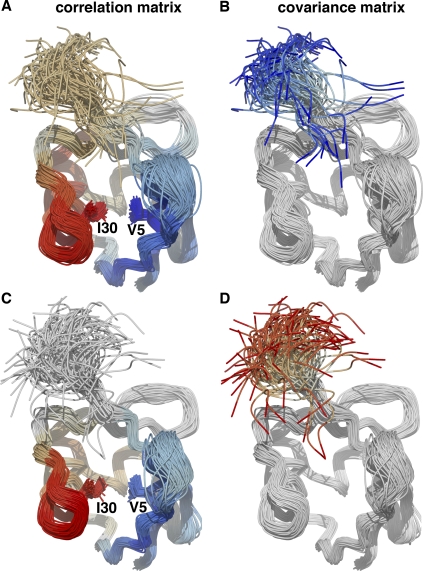
ML Superpositions and PCA Plots Derived from Two NMR Structural Ensembles of Ubiquitin(A) The first principal component from the correlation matrix is plotted on an ML superposition of the dynamic ensemble refined NMR solution structure of ubiquitin (PDB ID: 1xqq) [22],Ile30 (in red), and Val5 (in blue) pack together in the hydrophobic core of the protein. In this major mode of correlation, these two residues account for a large fraction of the correlation, and they move, on average, in opposite directions.(B) The first principal component from the covariance matrix, for the same 1xqq ensemble as in (A). The C-terminal tail (at top and in blue) is disordered largely because of a lack of NOE distance constraints. The low experimental precision of this region contributes to the large variance that dominates the largest principal component of the covariance matrix. The strong covariation in this region (indicated by blue) is thus an artifactual result of experimental uncertainty and dynamics rather than true correlated motion.(C) The first principal component from the correlation matrix is plotted on an ML superposition of an independent NMR solution structure of ubiquitin (PDB ID: 2nr2) [23].(D) The first principal component from the covariance matrix, for the same 2nr2 ensemble as in (C). Note that in the disordered C-terminal tail the red versus blue color is arbitrary.